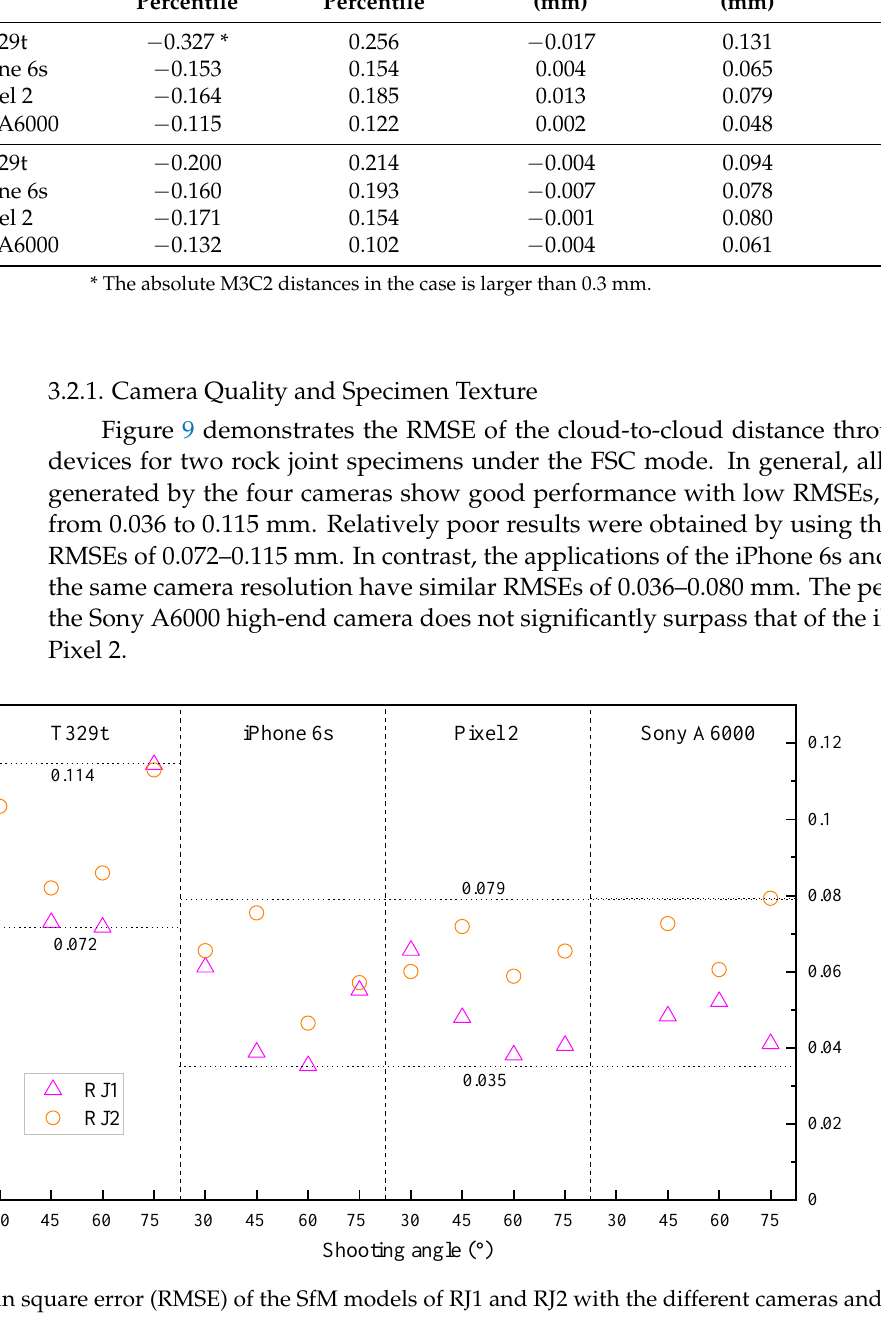
Table 6. The M3C2 distance between the HLS model and SfM model under the FSC mode. Specimen Camera